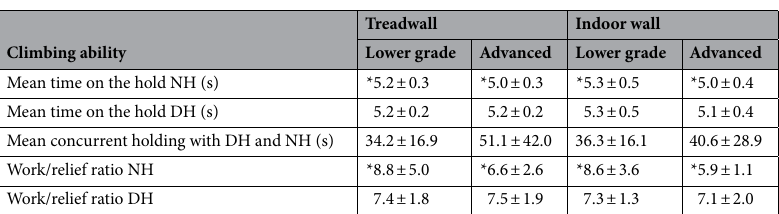
Table 2. Time motion analysis (mean ± s ) of treadwall and indoor wall climbing in lower grade and advanced climbers. NH non-dominant hand, DH dominant hand. *Statistical differences ( P ≤ 0.05) between lower grade and advanced